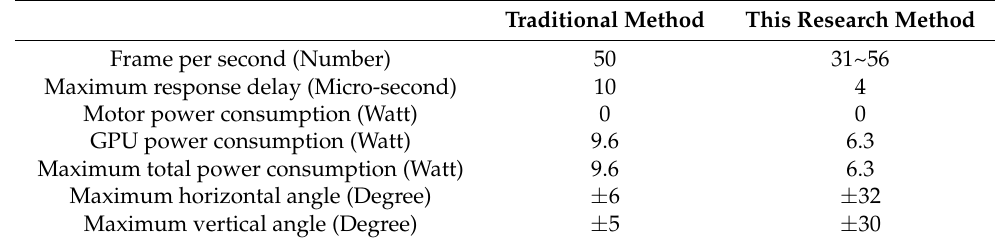
Table 3. Comparison table between the traditional method without motor drive and the method used in this study.